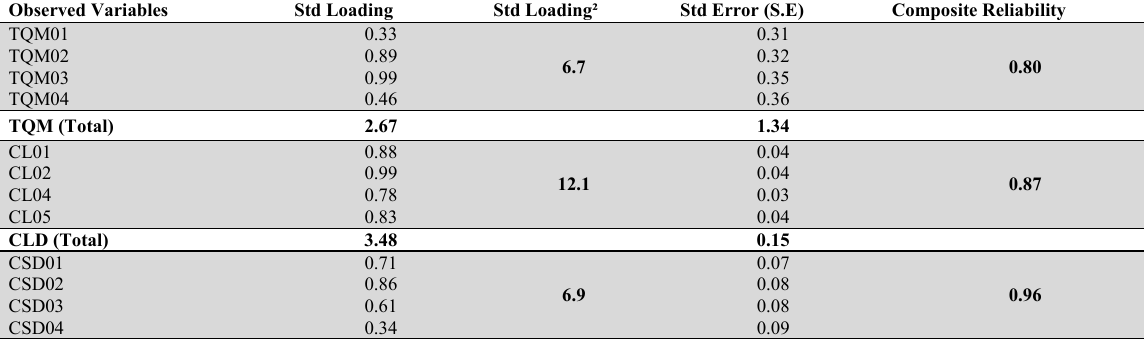
Composite reliability of IV, DV, and MV variables Observed